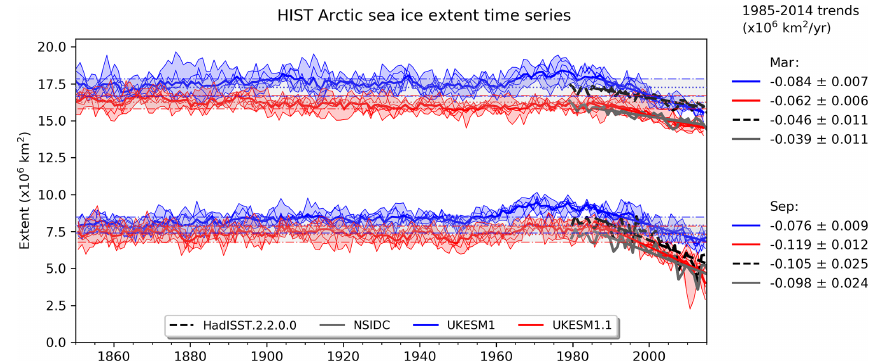
Figure 14. Time series of simulated (blue, UKESM1; red, UKESM1.1) and observed (black, HadISST; grey, NSIDC) sea ice extent in the Arctic for the months of March and September over the full historical period (1850–2014). The seasonal trends in the more recent period are shown for each dataset on the right-hand side. Model data represent the ensemble mean for UKESM1 (six members) and UKESM1.1 (six members), with the ± 1 standard deviation also shown.